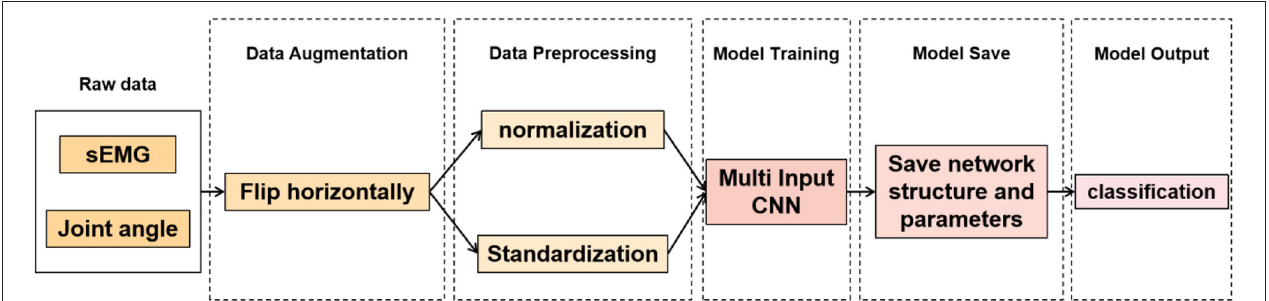
FIGURE 1 | Overall algorithm flow